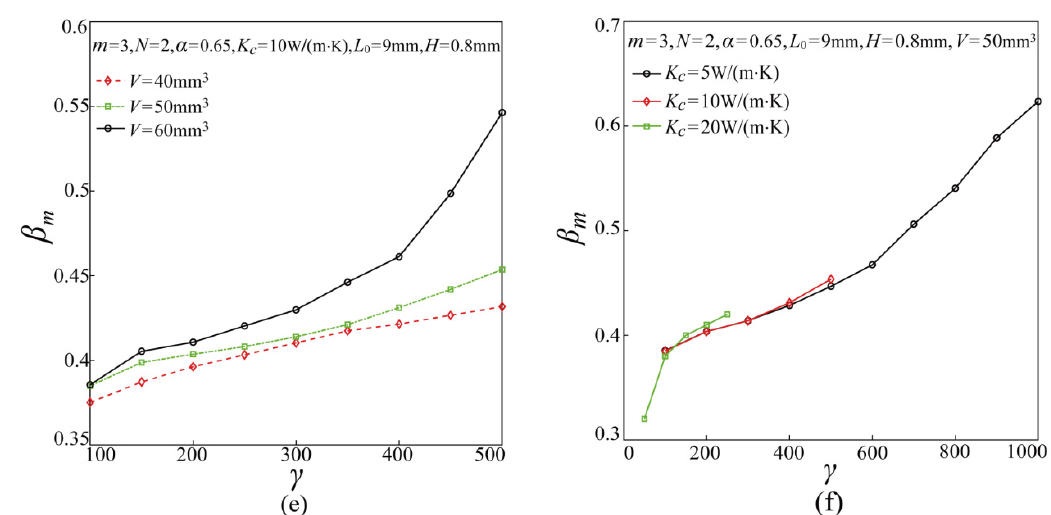
Figure 8. Effects of γ on the optimal width ratio of the HCM with different ( a ) α , ( b ) m , ( c ) L 0 , ( d ) H , ( e ) V , and ( f ) K c.